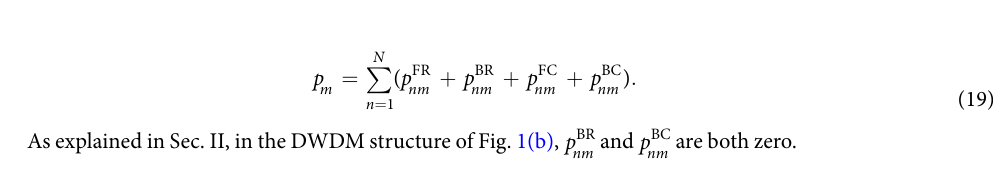
Table 1. Nominal values used for QKD system